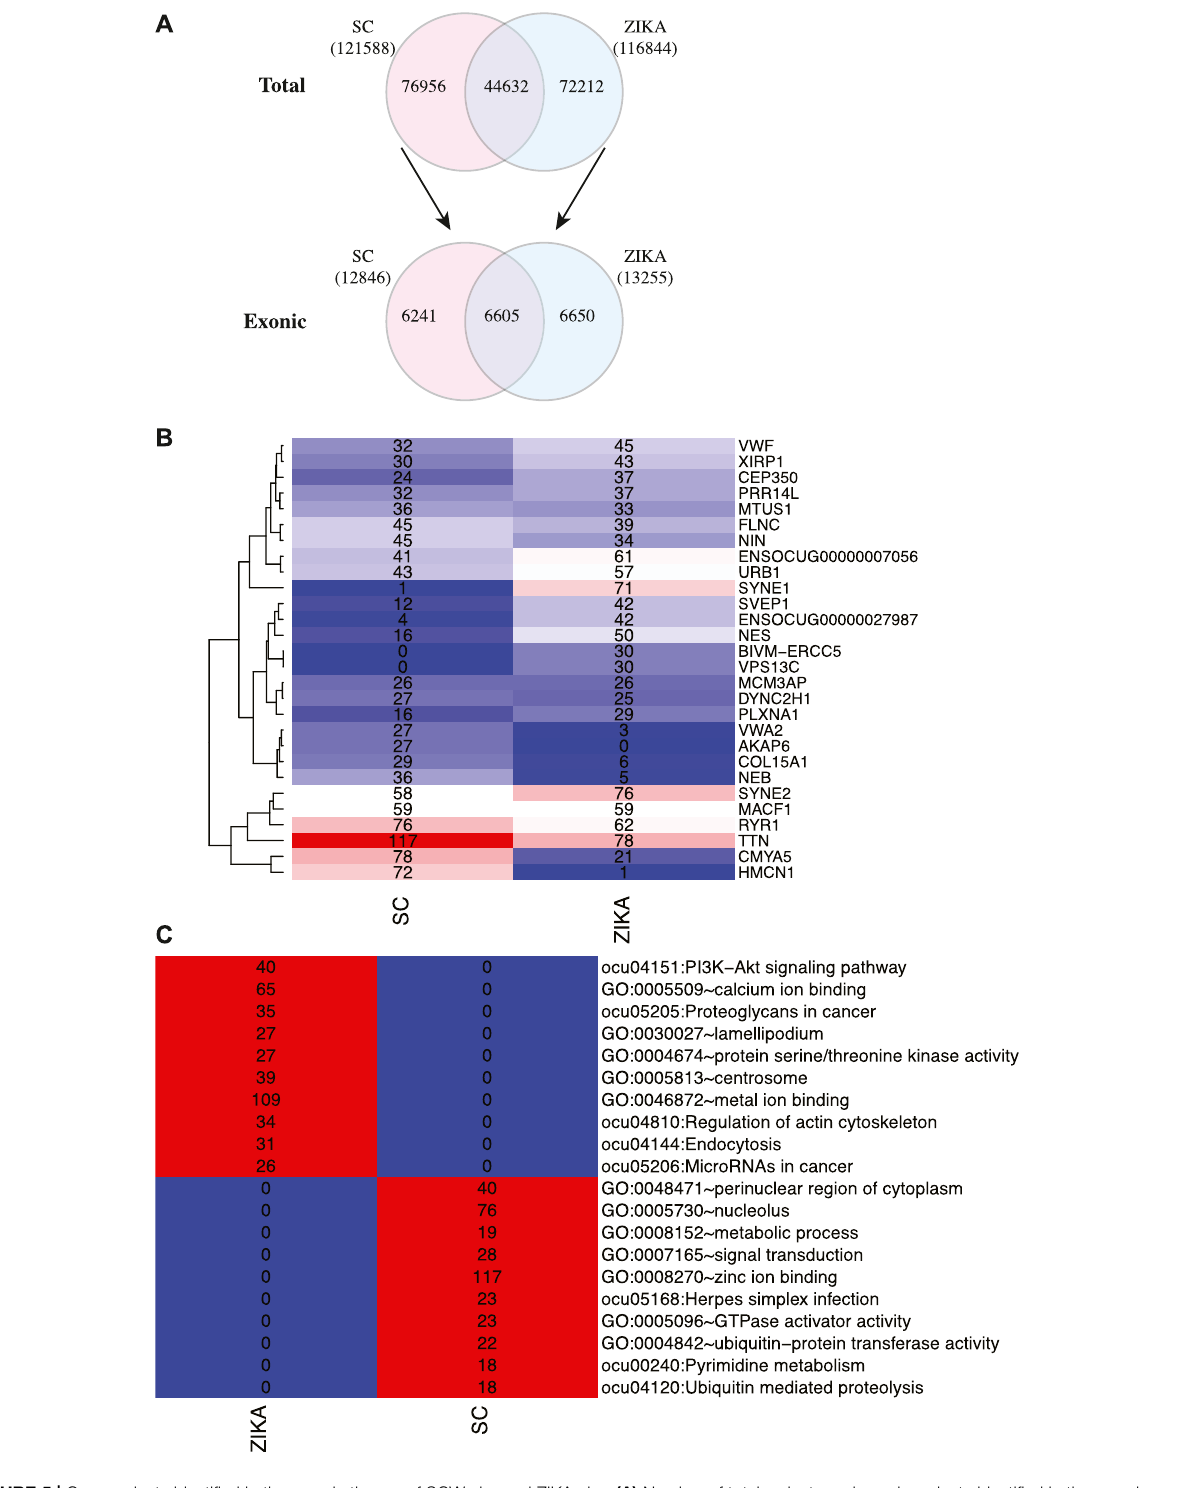
Frontiers in Genetics |